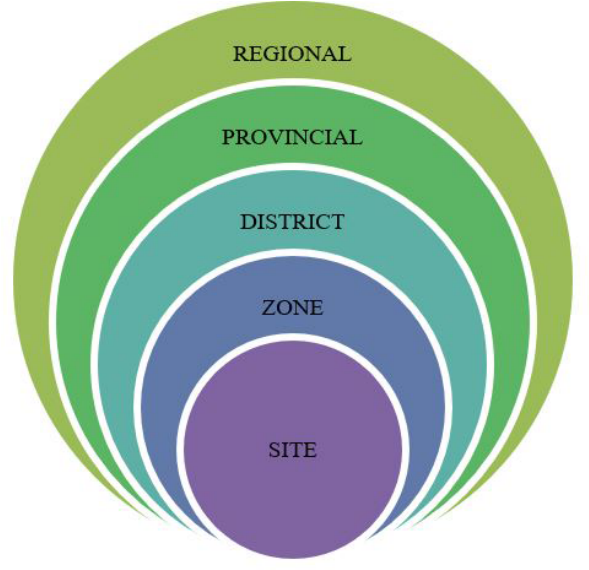
Figure 1. Hierarchical Multi-scale Levels for the Radon-prone Ar- eas in Campania